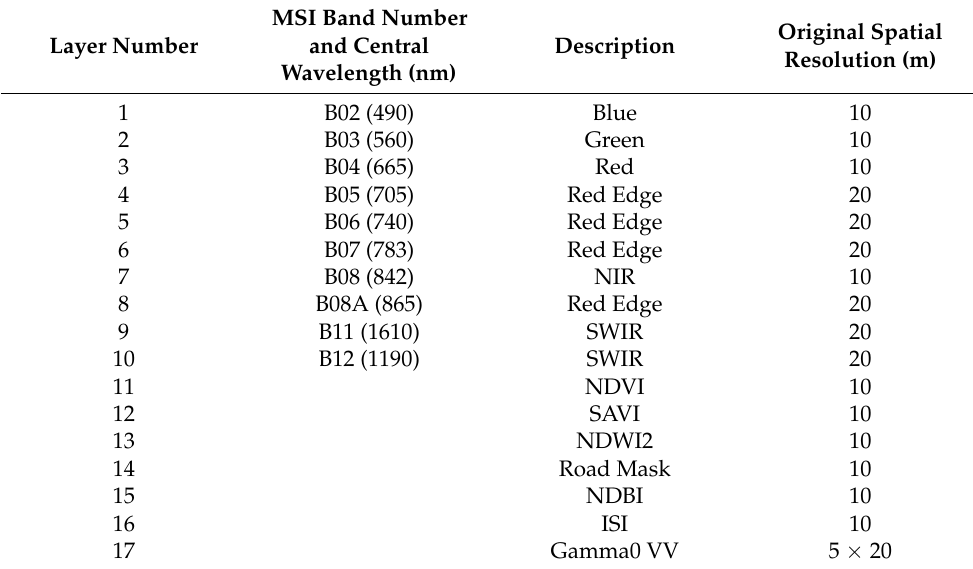
Table 2. Layers within the classification stack, including the spatial resolution and MultiSpectral Instrument (MSI) band and central wavelength for the Sentinel-2 reflectance bands. MSI Band